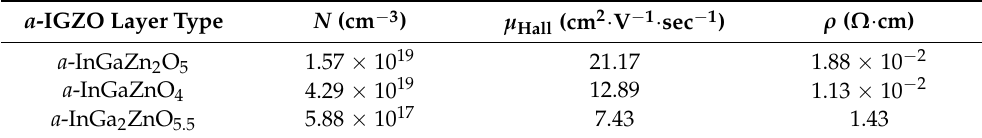
Table 3. Hall measurement result of the various a -IGZO thin films with Ar:O 2 = 20:1.2 (sccm). a -IGZO Layer Type